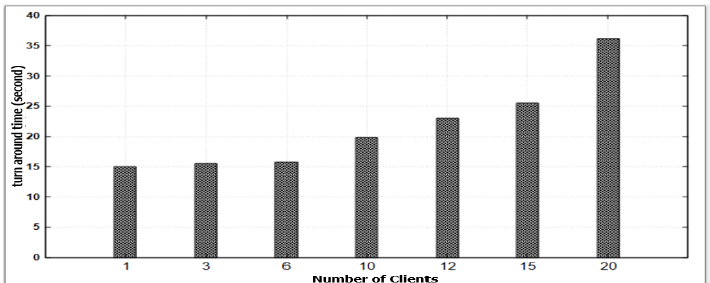
Figure 3. Observation 1: performance degrades as clients increase, which causes the risk of SLA (Service- Level Agreement) violation.